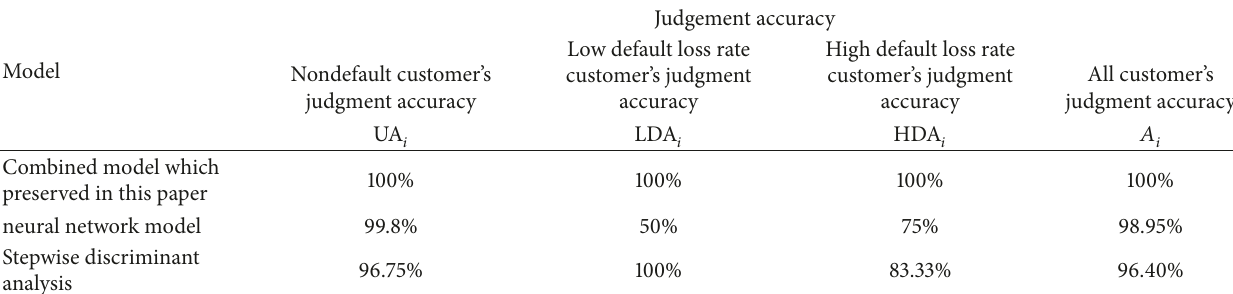
Table 6: Comparative analysis of 3